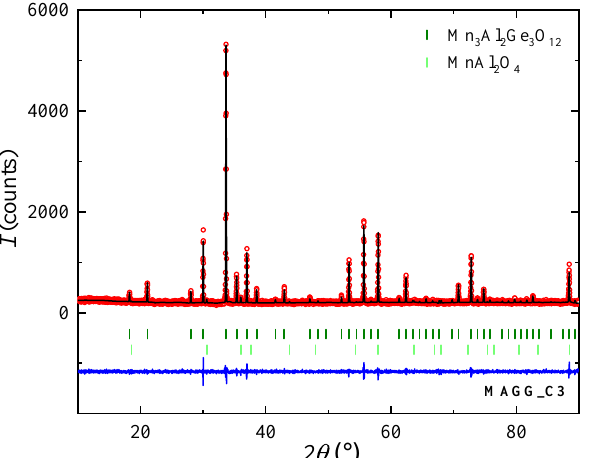
Figure 8. PXRD profile of a ground crystal fragment isolated from the MAGG_C3 boule. The red open circles represent the experimental profile and the black line is the calculated profile, with the difference given by the blue line. The reflections of the Mn 3 Al 2 Ge 3 O 12 garnet structure are indicated by dark green “ (cid:120) ” while the reflections of the cubic ( Fd ¯ 3 m ) MnAl 2 O 4 impurity are represented by light green “ (cid:120) ”.